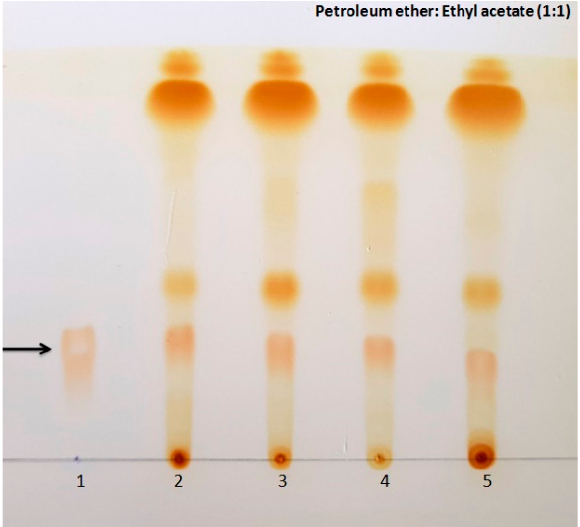
Figure 4. Thin layer chromatography developed in petroleum ether: Ethyl acetate (1:1) showing spots of beauvericin detected using iodine vapours. Black arrow shows spots of beauvericin (1) Standard beauvericin (500 µg/mL) (2) Fusarium tardicrescens NFCCI 5201 (3) F. cugenangense NFCCI 2872 (4) Neocosmospora vasinfecta NFCCI 2960 (5) Fusarium annulatum NFCCI 2962.